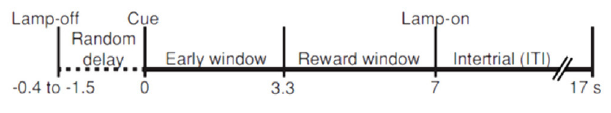
FIGURE 1 | Hamilos et al. (14), with permission (Creative Commons Attribution License permits unrestricted use and redistribution provided that the original author and source are credited). Abbreviations are those used in the text. Schematic of self-timed movement task in Hamilos et al. (14). After